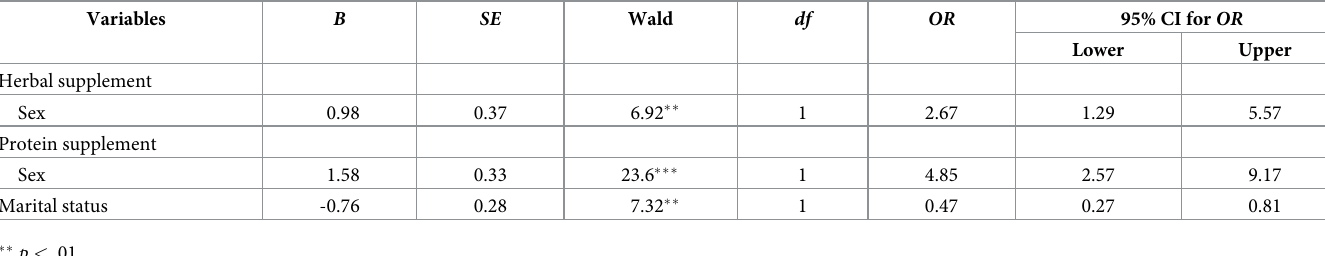
Table 3. Logistic regression results for herbal and protein intake across sexes (N = 275).